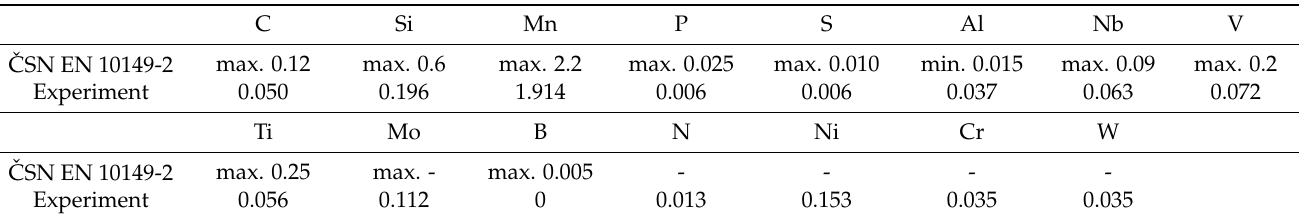
Table 1. Chemical composition (wt. %) of the S700MC steels.